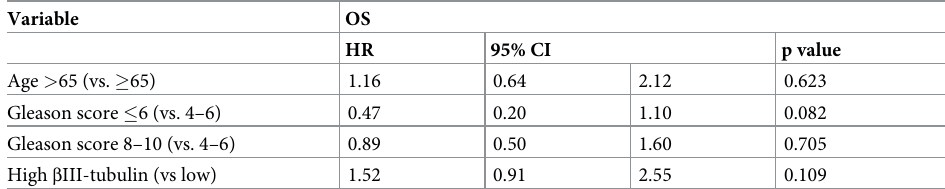
Table 5. Multivariate analysis of